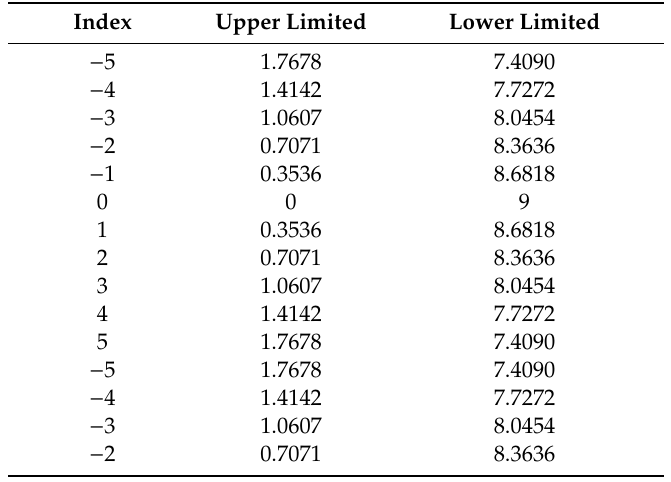
Table 1. Range of multi-point sequential focus frequency offset function parameter g ( n ).